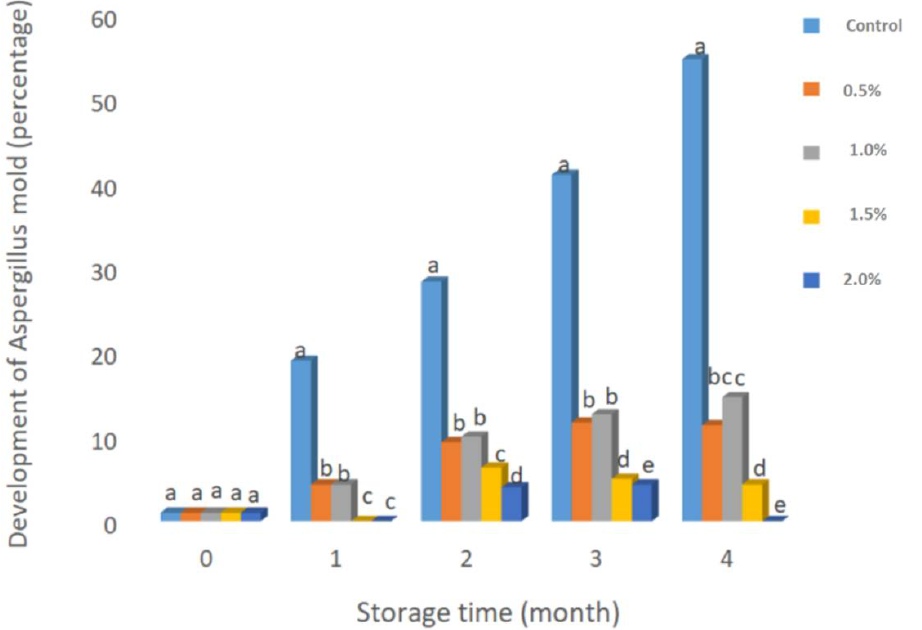
Figure 3. Percentage of the growth of Aspergillus species on almond uncoated (control) and coated with different concentrations of mastic gum during 4 months of storage. Different lowercase letters indicate a statistically significant differences ( p < 0.05) between the samples during each month; share a lowercase letter are not statistically different, while different letters denote for statistical differences at least 95%